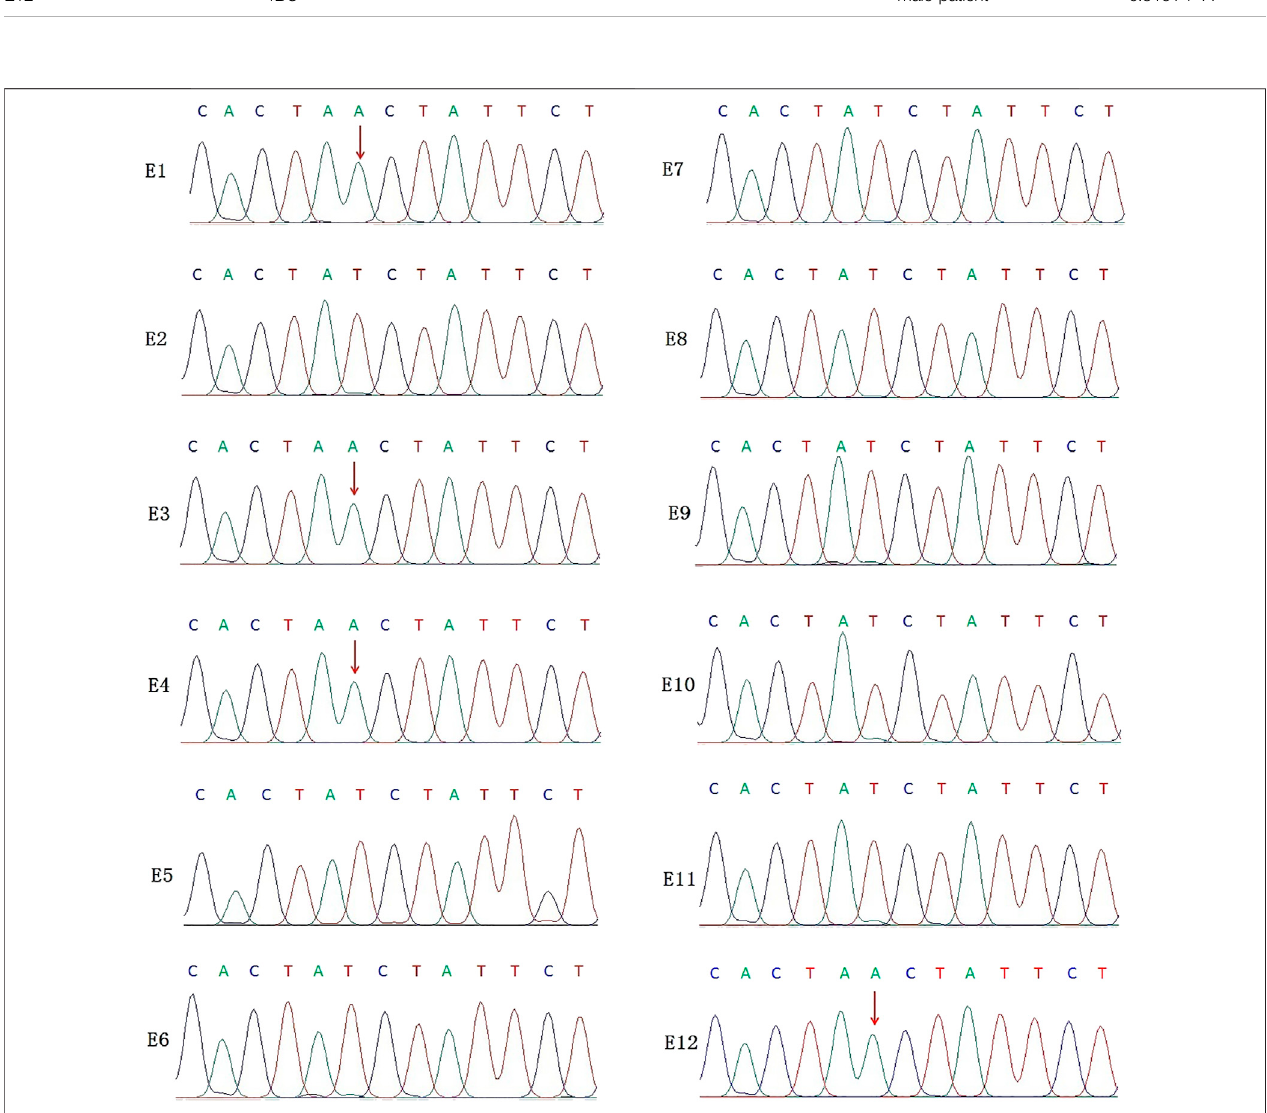
FIGURE 2 | Results of the Sanger sequencing for biopsied TE cells. The fi gure shows that E1, E3, E4, and E12 are carriers of the IL2RG c.315 (T > A) variant; no variants were detected in the remaining embryo samples. For X-linked recessive diseases, this technique alone cannot distinguish between male patients and female carriers. At the same time, misdiagnosis lead by ADO cannot be ruled out.